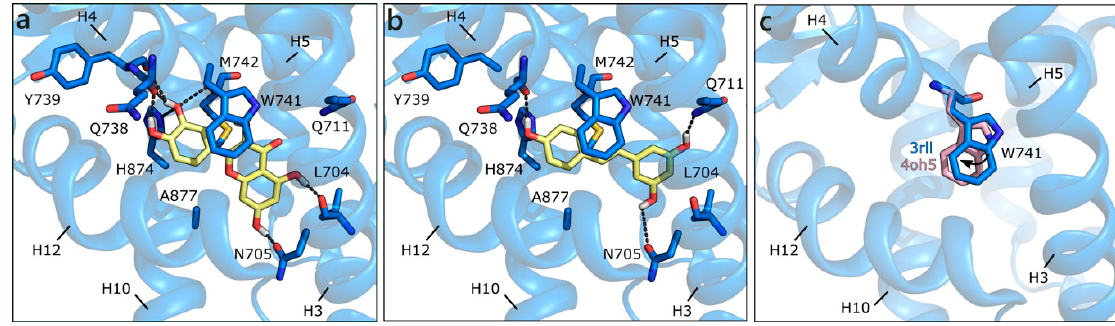
Figure 4. Docking poses of QRC ( a ), and RESV ( b ) in AR T877A (PDB ID 3rll [57]). ( c ) Different orientations of Trp741. The protein is shown in transparent blue cartoon, the residues lining the binding site, and the ligands are shown in capped sticks and colored blue and yellow, respectively. Helices and residues lining the pocket are labelled, hydrogen bonds are displayed as black dashed lines.